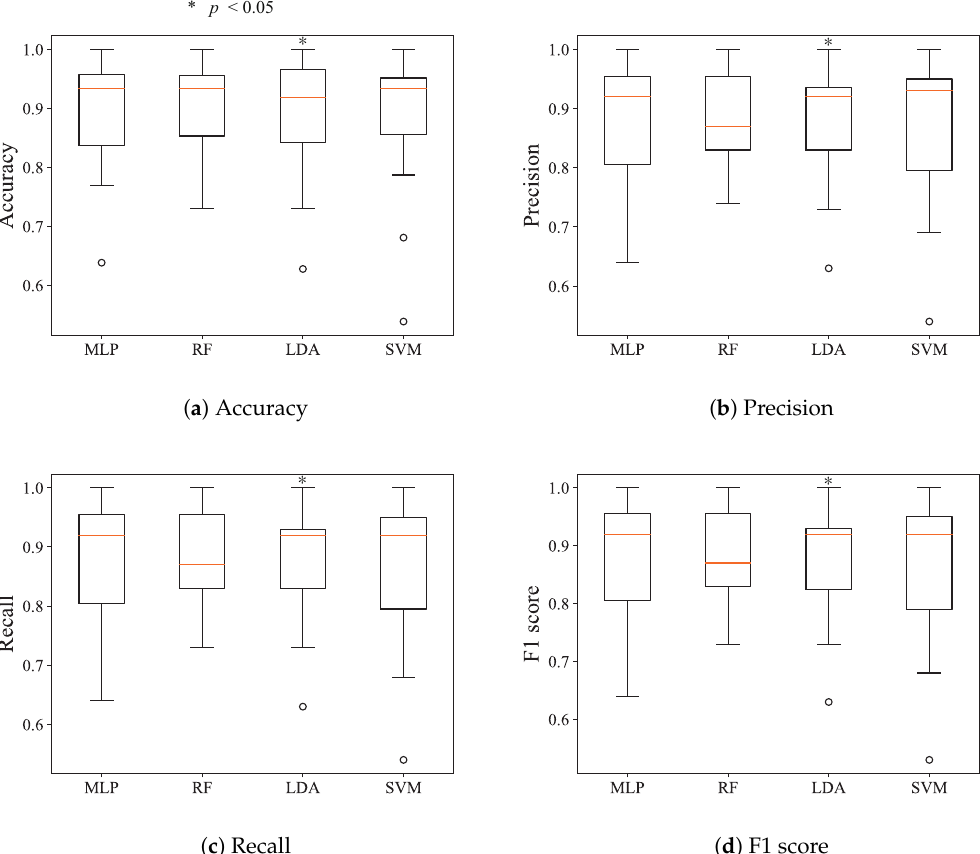
Figure 8. Boxplots of the accuracy, precision, recall, and F1 score using the features selected by the DQN